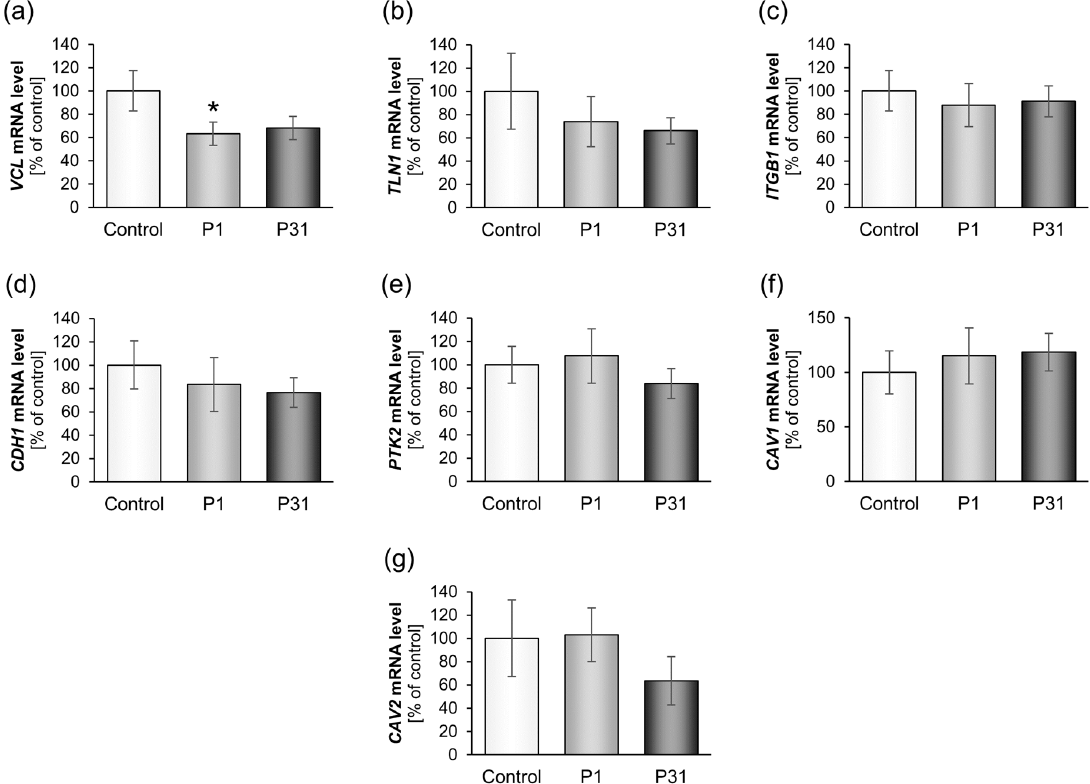
Figure 5. Influence of short-term microgravity on the expression (mRNA) of focal adhesion complex components. The data is given as mean ± standard deviation. * p < 0.05 vs. Control.